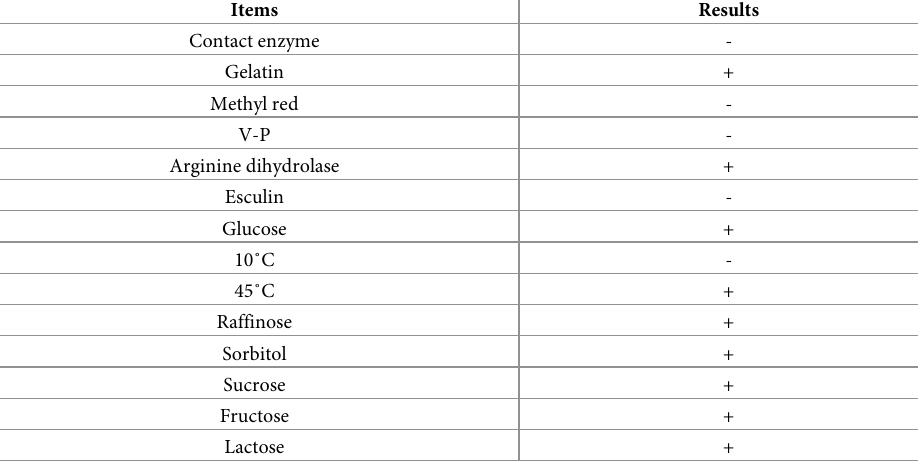
Table 2. Physiological and biochemical characteristics of